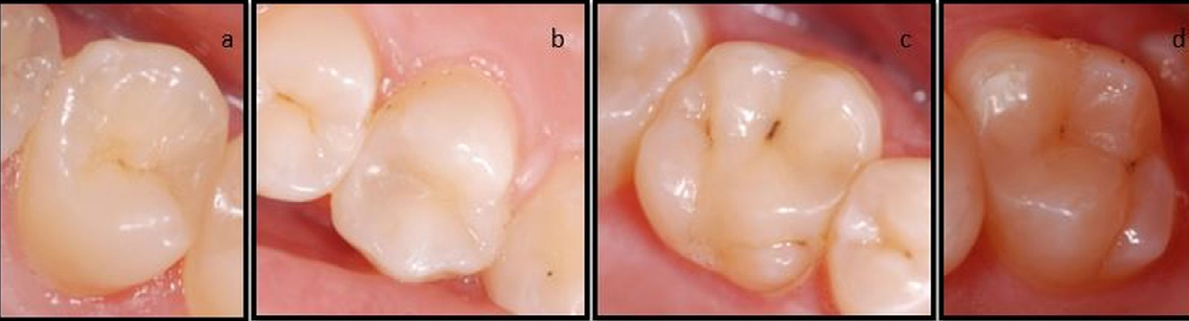
Figure 6- a,b) Restorations scored as “Alpha” for all criteria in the FBF group at one-year evaluation. c,d) Restorations scored as “Alpha” for all criteria in the CSC group at one-year